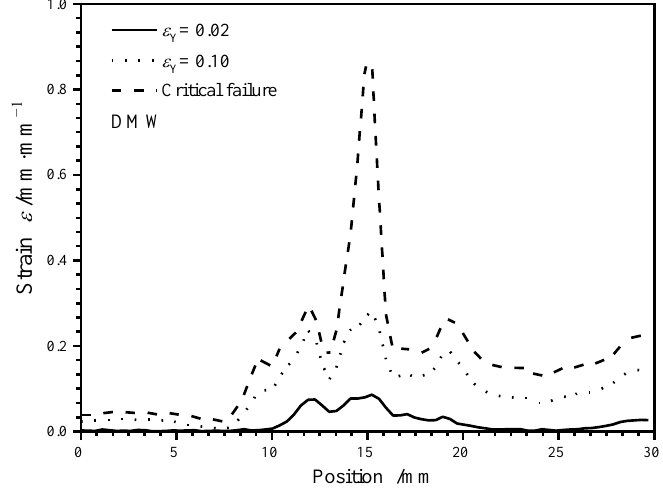
Figure 16. Strain variation curves in the width direction at the middle of the